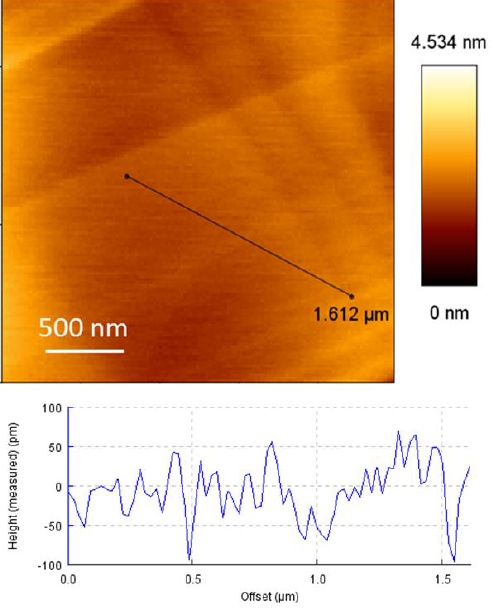
Figure 3. Typical AFM height image and corresponding cross-section analysis of the graphite surface prepared by mechanical exfoliation of an HOPG